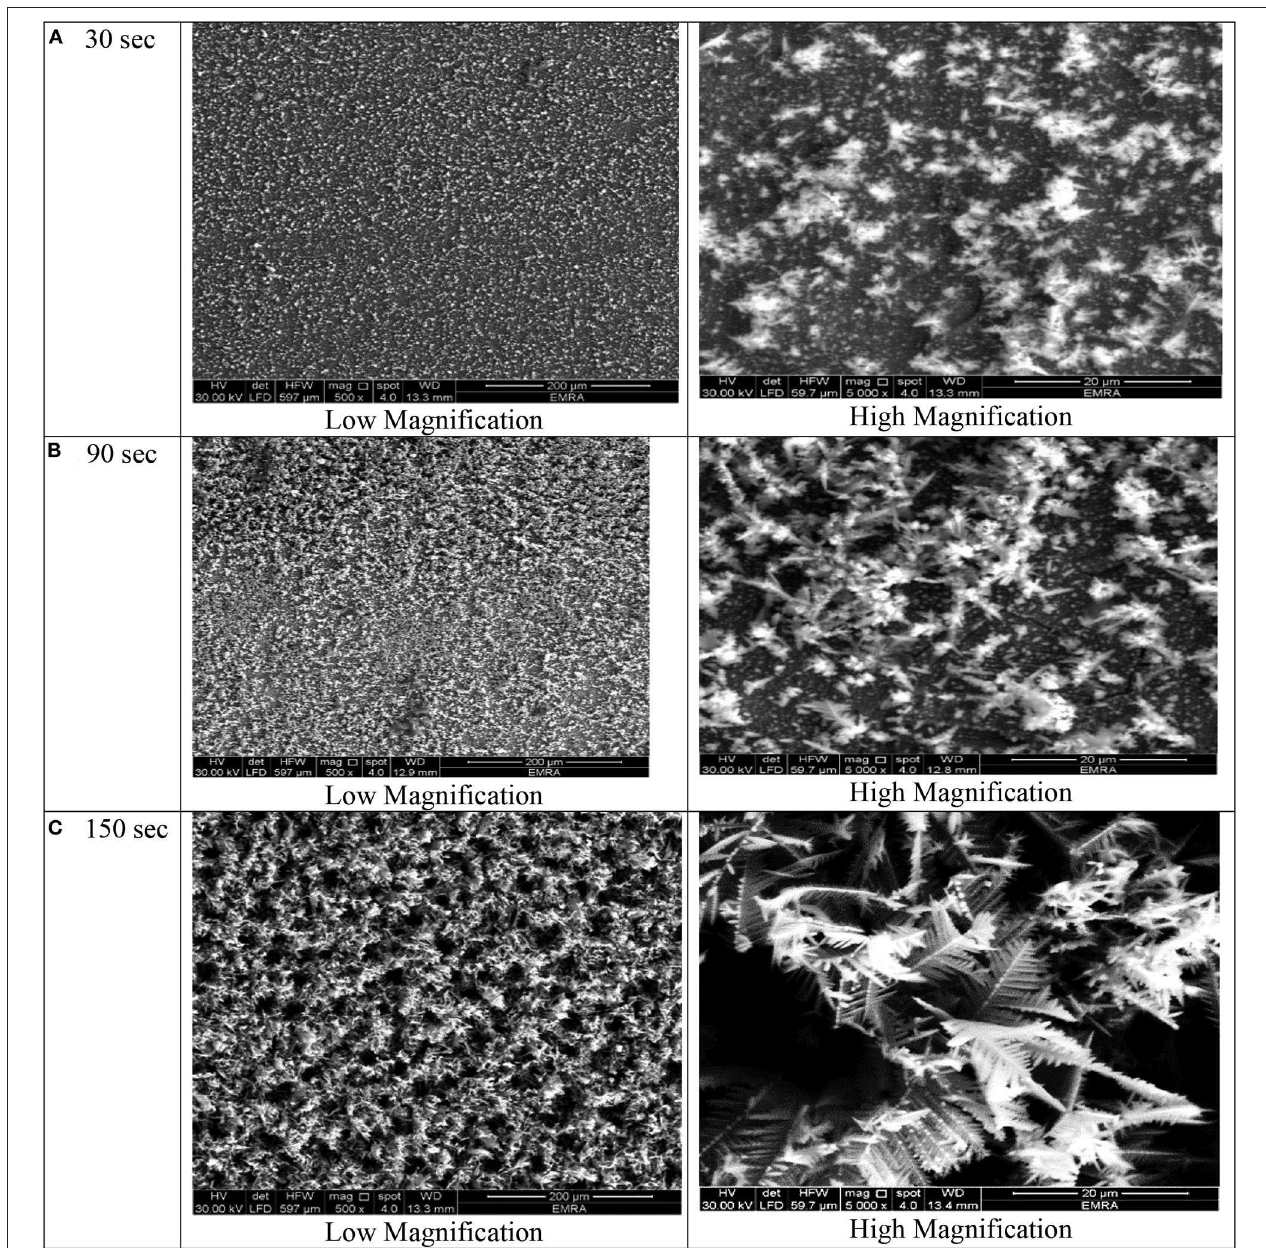
FIGURE 4 | SEM micrographs of porous Ni–Cu layers electrodeposited on AISI 304 stainless steel for (A) 30s, (B) 90s, (C) 150s at current densities of 1.8 mA/cm 2